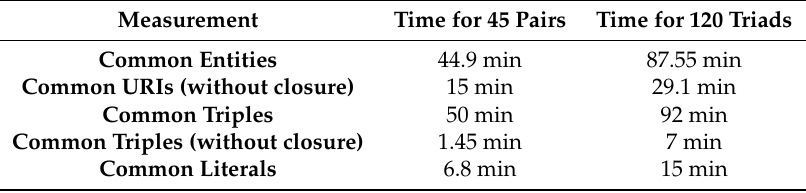
Table 6. Execution time for SPARQL queries for measuring the connectivity of 10